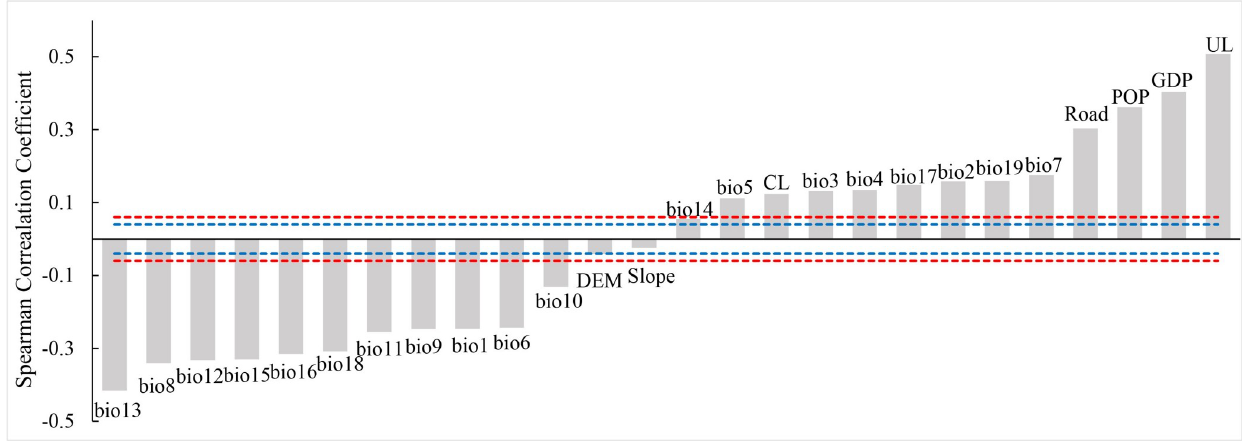
Fig 2. Correlation analysis between DF and different environmental variables. (Blue dotted line indicates p < 0.05 and the red dotted line indicates p < 0.01. CL: cultivated land, Road: road density, GDP: gross domestic product, POP: population density, UL: urban land).